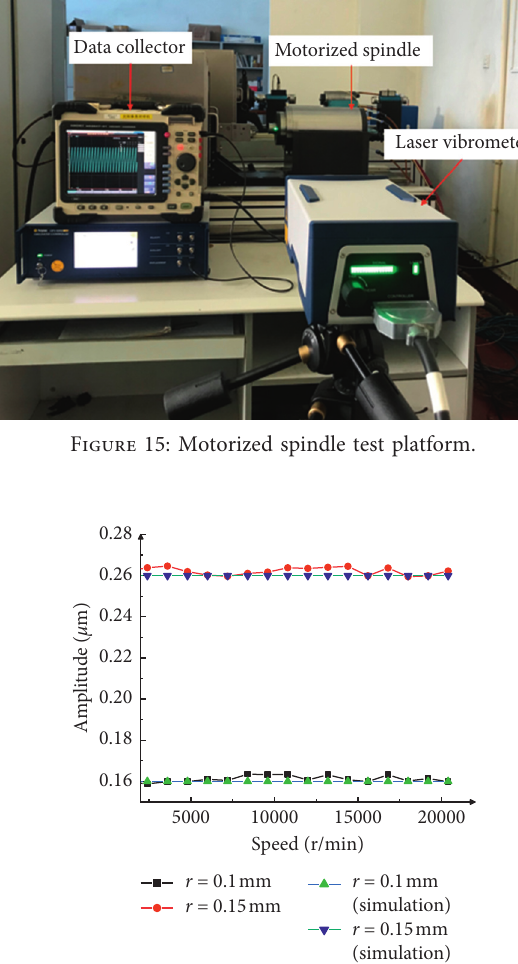
Figure 16: Comparison between simulation and